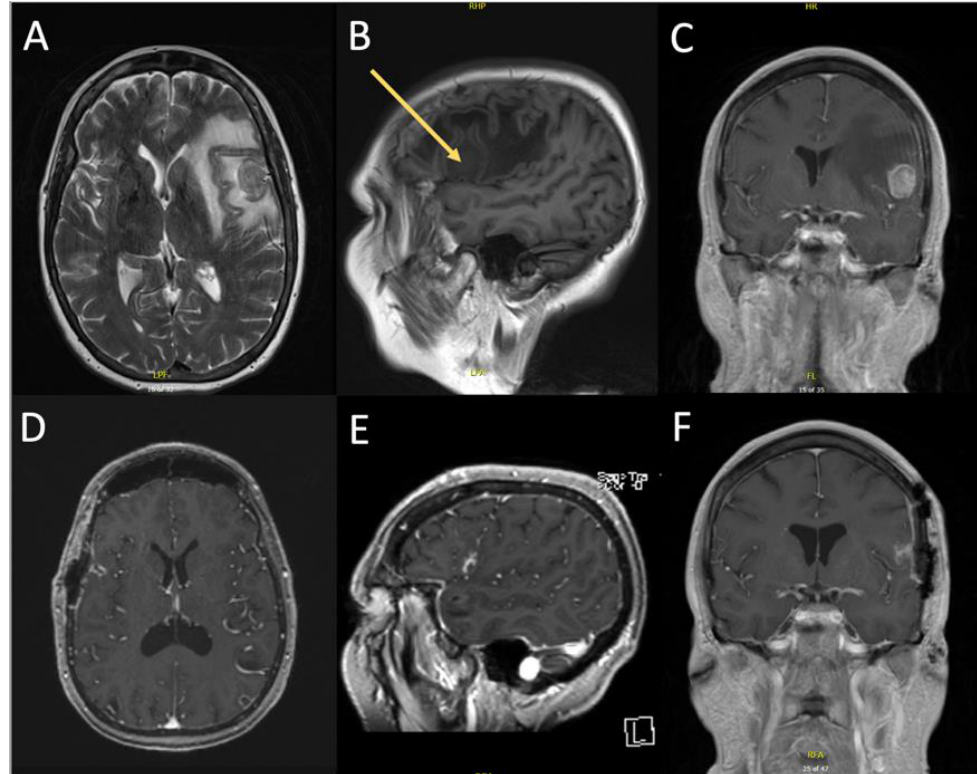
Figure 3. Preoperative MRI (top images) compared with 15-day postoperative MRI (bottom images). Image ( A ): Axial weighted T2 demonstrating extensive edema associated with lesion seen as a hyperintense signal with midline shift. Image ( B ): T1 MRI pre-Gd showing a hypointense, rounded, well-defined lesion within pars triangularis of the left inferior frontal gyrus (IFG). Vasogenic edema is visible as a hypointense signal. Image ( C ): T1-Weighted coronal view with contrast demostrating homogenous enhancement of the lesion and clear visualization of its margins. Ipsilateral collapsed lateral ventricle and midline shift secondary to surrounding hypointense edema is present. Image ( D ): Weighted T1 post-Gd with complete resection of the lesion. There is a small pneumocranium and a hyperintense signal beneath the craniotomy representing a small subarachnoid hemorrhage. Image ( E ): T1 weighted MRI showing a small hyperintense signal in the left IFG where the metastasis was previously located. Peritumoral edema is not present compared to before surgery. Image ( F ): Coronal weighted T1 post-Gd giving another view of the complete resection of the lesion with craniotomy, small hyperintense subarachnoid hemorrhage, and small pneumocranium. The previously collapsed left lateral ventricle is nearly symmetrical due to reduced